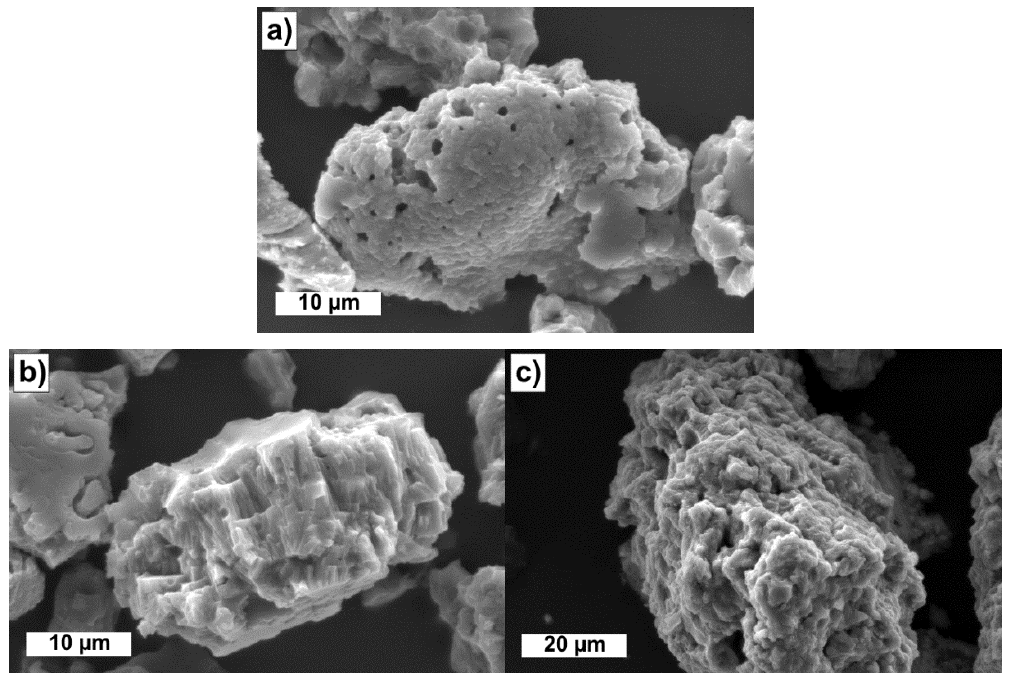
Figure 10. ( a ) Partially molten agglomerated and sintered Al during cavitation erosion test (APS_AT2); ( b ) Well-melted region of the same coating removed during cavitation erosion test (APS_AT2); ( c ) Large debris particle from HVOF_AT2